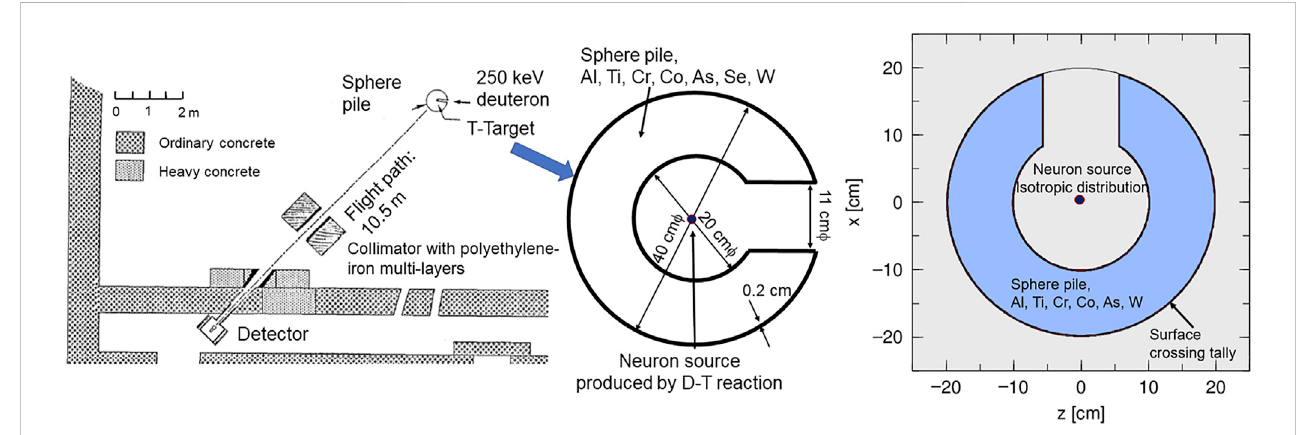
FIGURE 2 Arrangement of the experimental con fi guration and modeling geometries for the OKTAVIAN experiments.